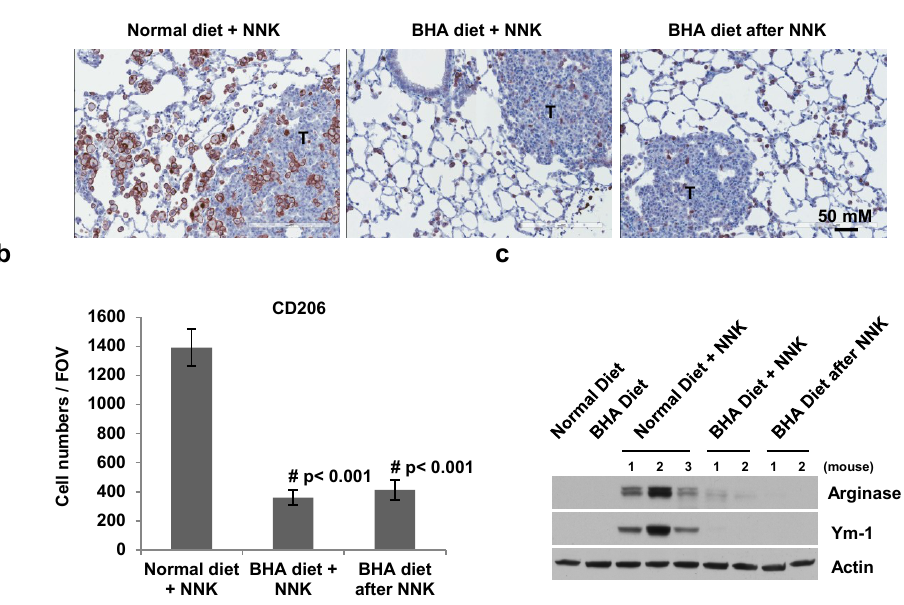
Figure 5. BHA specifically blocks NNK-induced occurrence of TAMs in lungs. ( a ) A/J mice were maintained on normal or BHA diet for 2 weeks prior to NNK injection or BHA diet 1 week after NNK treatment. Lungs were collected at 6 months after NNK treatment and sectioned and immunostained for CD206. Representative images are shown (T: tumor area); ( b ) Quantitative analysis of ( a ) is shown. The CD206 + cells were evaluated by counting 10 high power fields (20×) per lung section (1 mm)/2 tissue sections/mouse. n = 10 mice; ( c ) Lung tissues from ( a ) were analyzed by western blotting with anti-arginase I, anti-Ym-1 and anti-actin antibodies. Representative images are